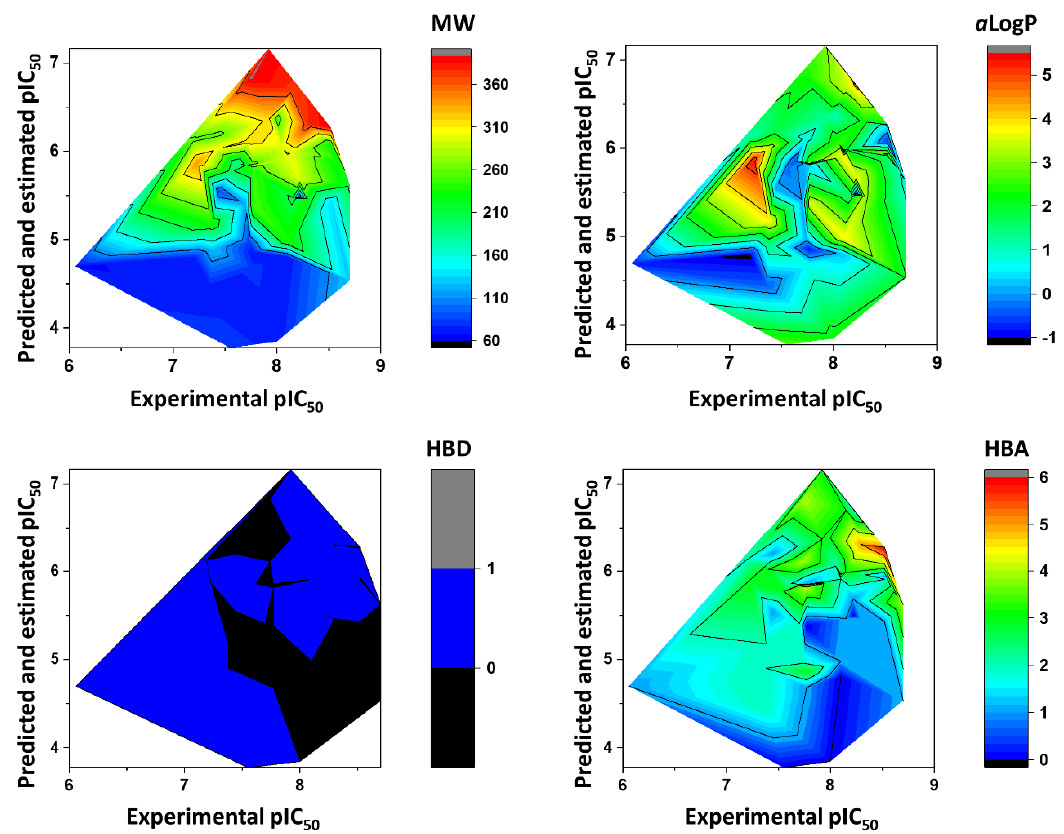
Figure 8. Heat maps showing the correlation between physicochemical properties and biological activity for molecular fragments extracted from the dataset. Note: MW = molecular weight; a LogP = octanol-water partition coefficient; HBD = hydrogen bond donors; HBA = hydrogen bond acceptors.